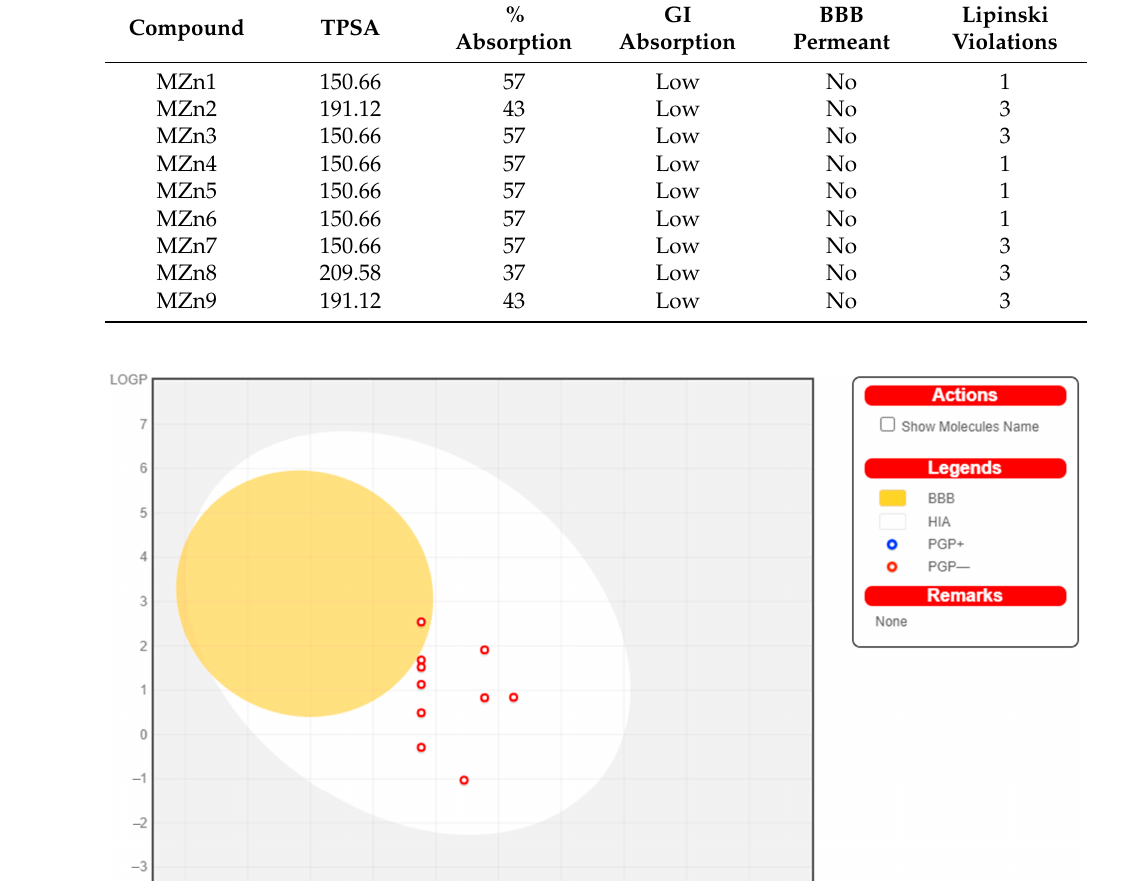
3 Figure 3. Swiss ADME Analysis of MZn1–MZn9.